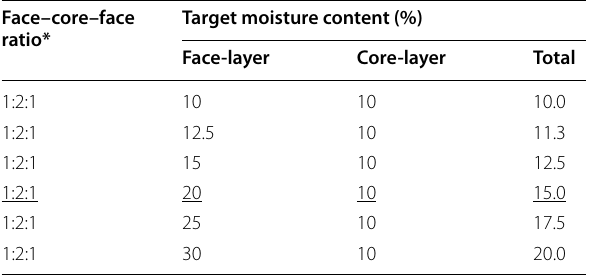
Table 1 Series of experimental mats for evaluating the effect of face-layer moisture content (MC) Face–core–face ratio*